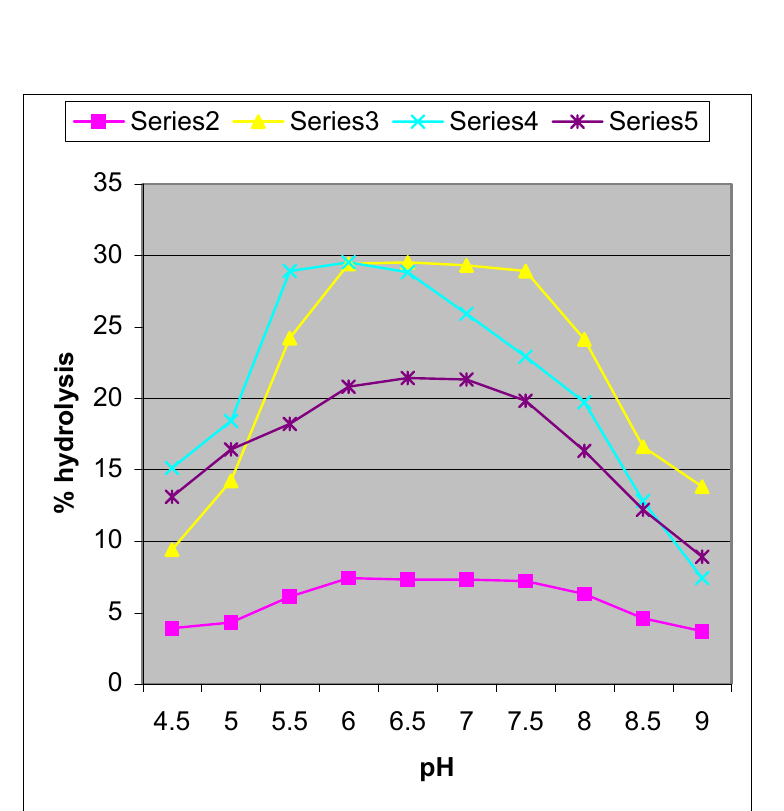
(H O) ] 3+ , (where N = (tn) ,[series2]; (tme) 4 2 2 4 2 4